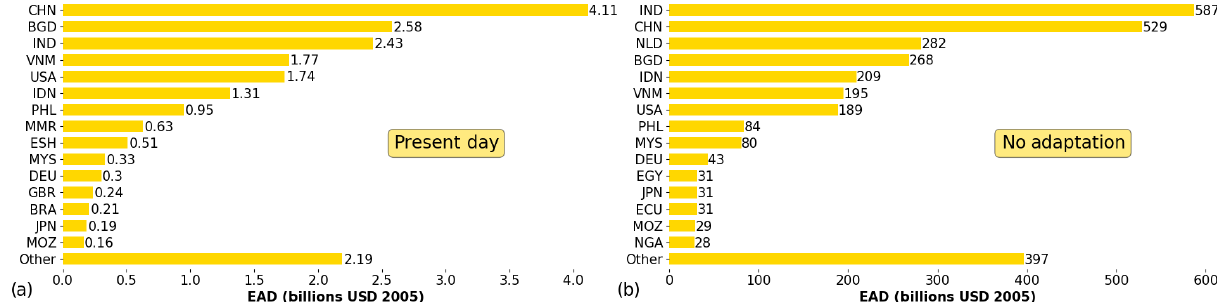
Figure 3. Top 15 countries with coastal flood risk in (a) current conditions and (b) 2080 if no adaptation takes place for the scenario RCP4.5–SSP2. Note that the countries and value on the x axis change for each graph. The countries are denoted by ISO 3166-1 alpha-3 codes. Table 1. Global overview of benefit–cost analysis for the different adaptation objectives (benefits, costs, and NPV are in USDbillion